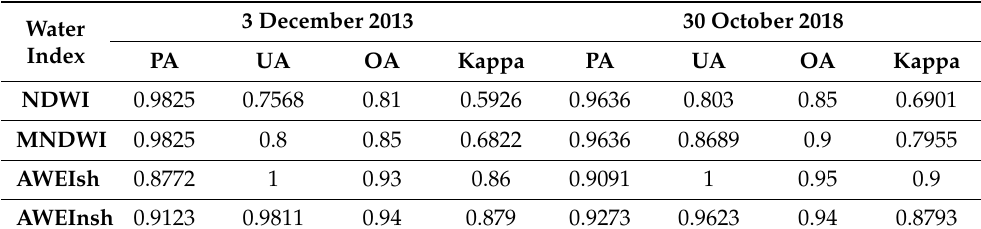
Table 8. Zengwen River: Accuracy of spectral water body indices in terms of water body extraction on different dates.